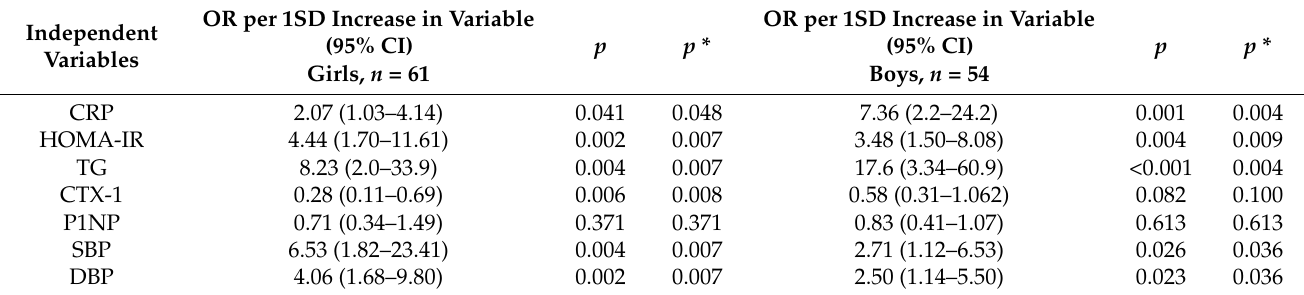
Table 3. Associations of individual risk factors and biomarkers of bone metabolism with the presence of MetS in univariate logistic regression models stratified by sex.